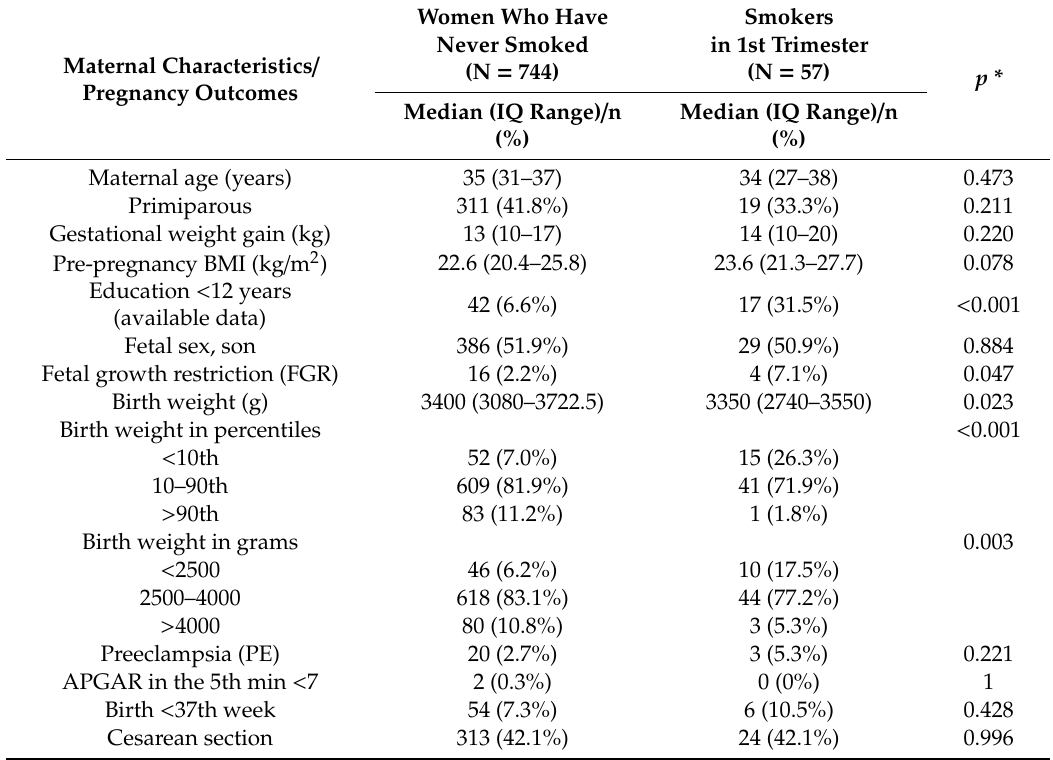
Table 1. Basic characteristics of the women who smoked in the 1st